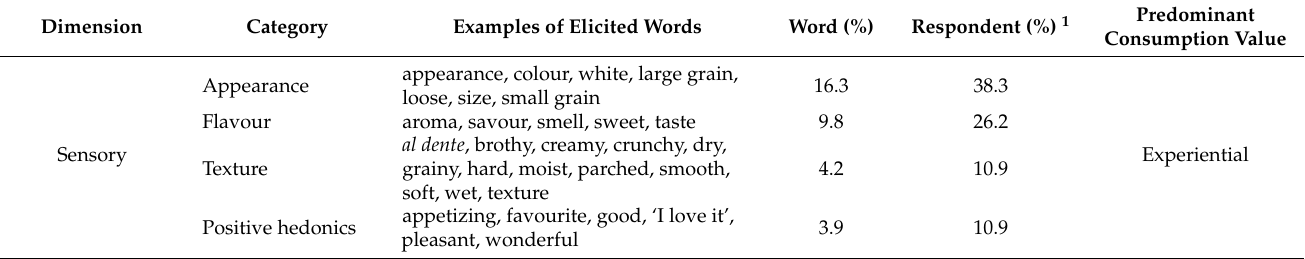
Figure 2. Frequency of respondents (%) describing words according to the dimensions for the “rice” stimulus. Table 2. Frequencies of words and respondents (%) according to each dimension and category for the “rice” stimulus. The predominant consumption value associated with the words within each dimension is also